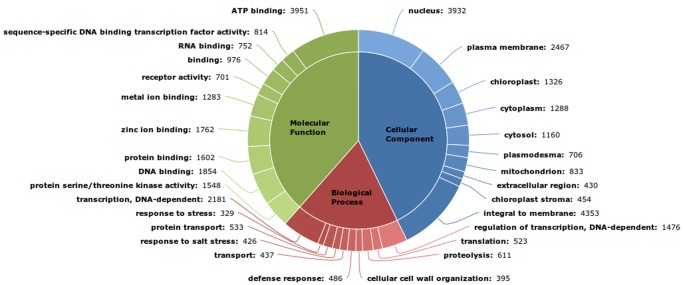
Top ten most represented GO terms in each of the three GO domains.